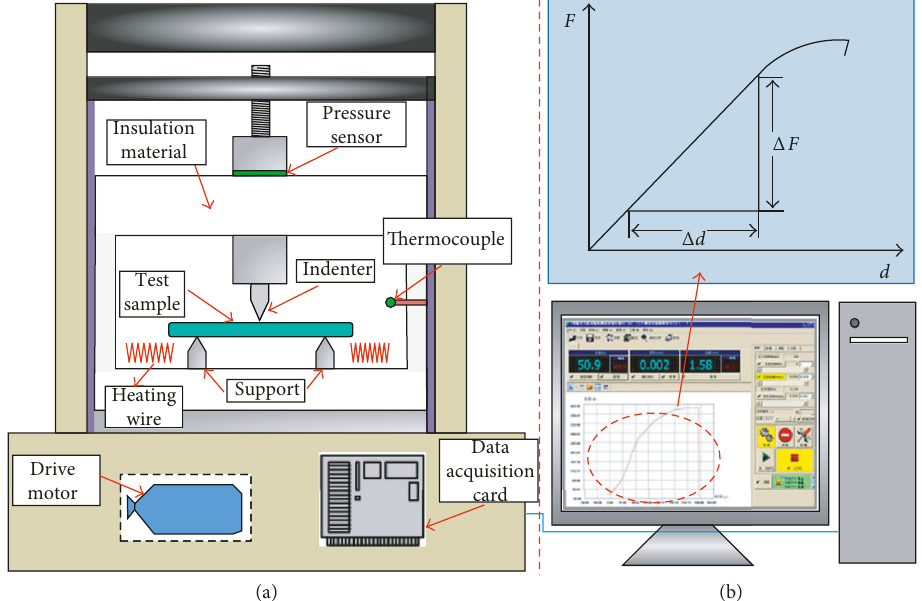
Figure 2: The schematic of the flexural test system: (a) three-point bend test structure and (b) software processing